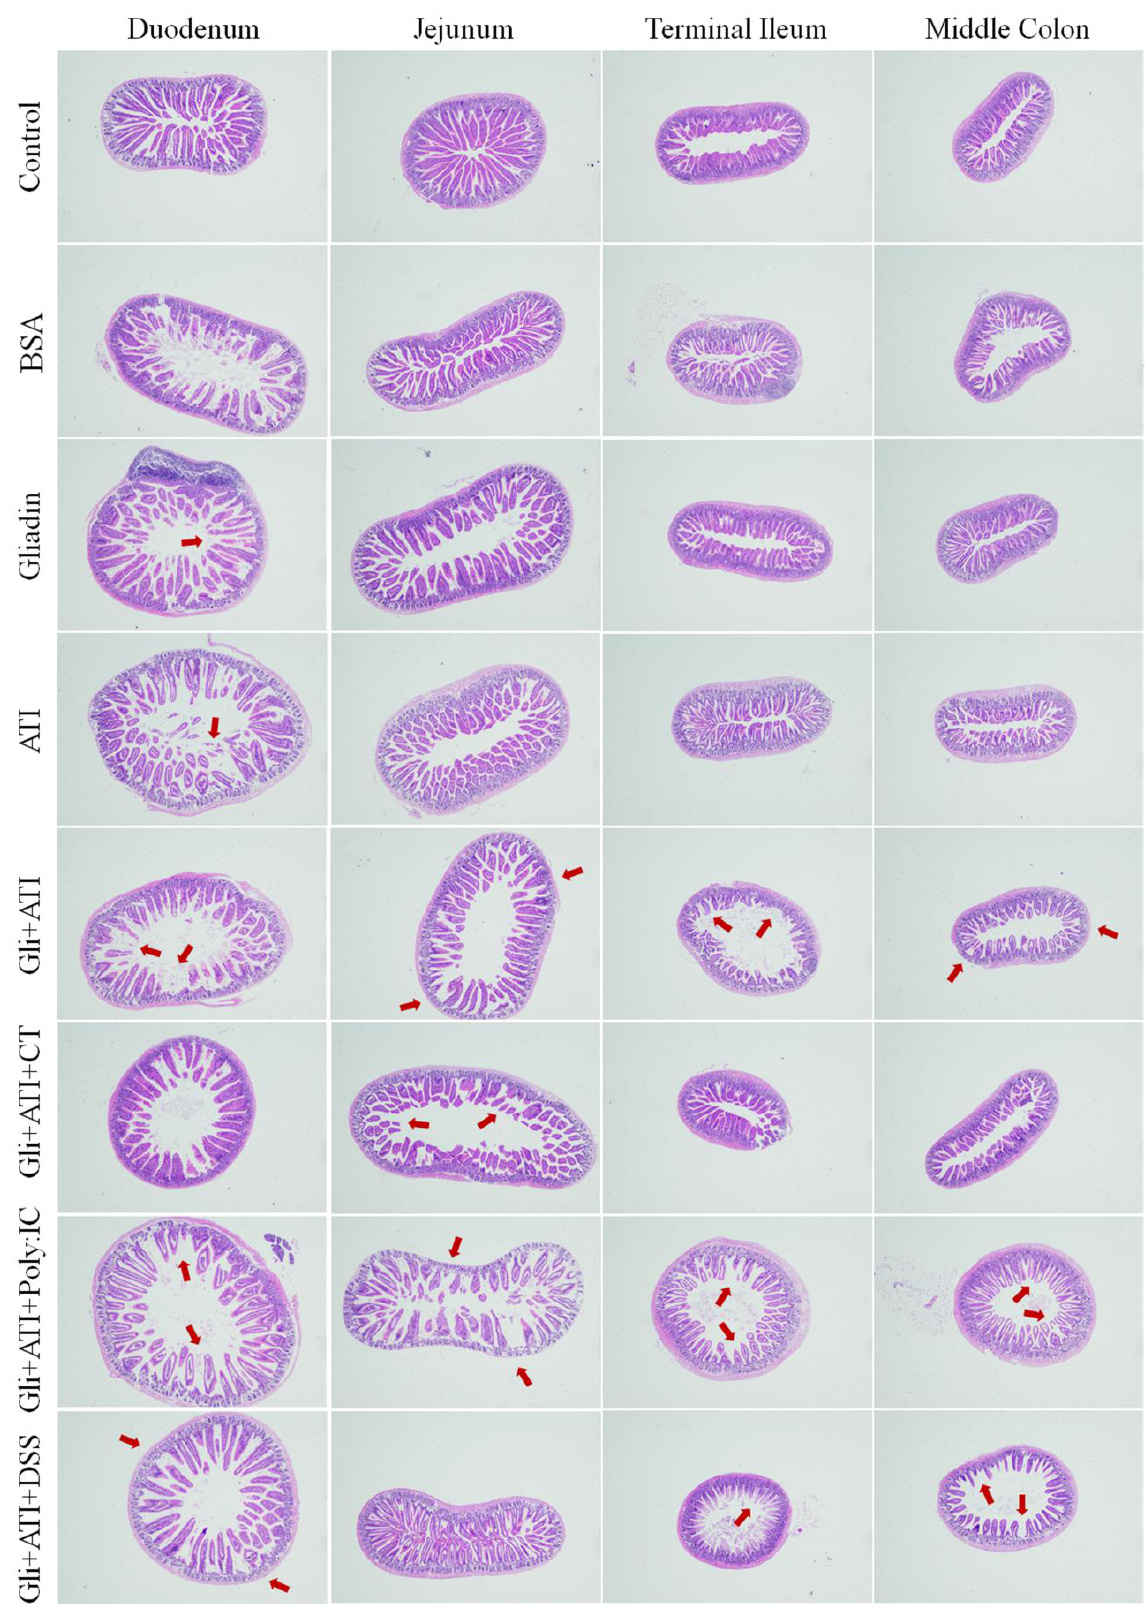
Figure 3. Intestine histological sections of terminal ileum, middle colon, jejunum and duodenum stained with hematoxylin and eosin stain. The images are the fields of view at 40× lens.